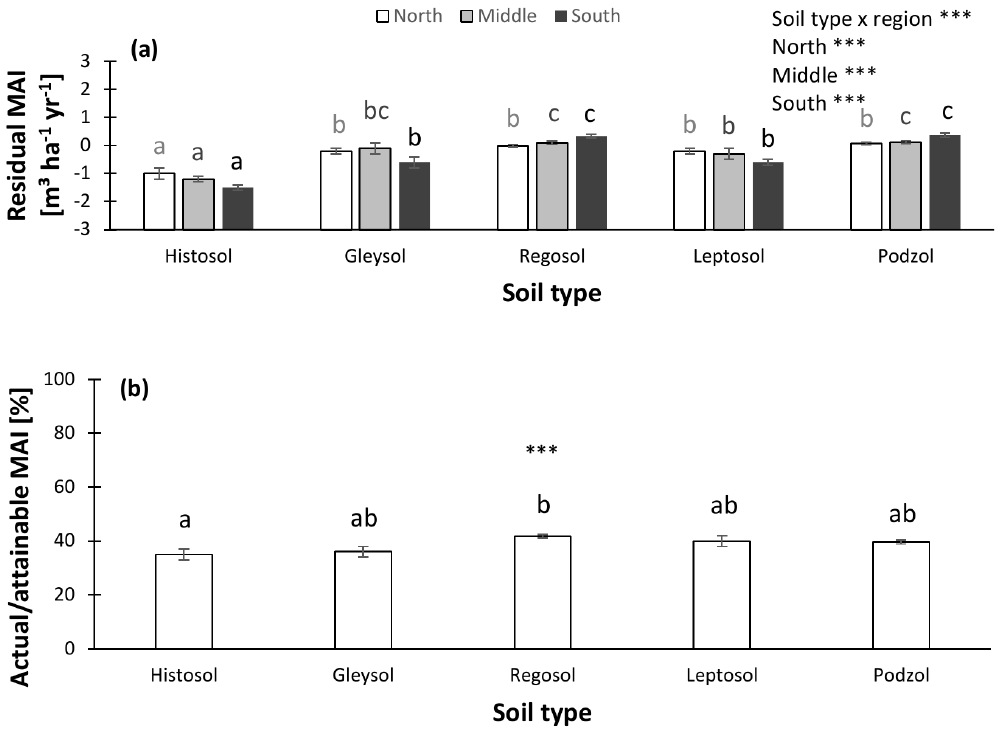
Figure 6. Normalized productivity per soil type. (a) Productivity normalized following method 1 (residual mean annual increment – MAI) vs. soil type. (b) Productivity normalized following method 2 (actual / attainable mean annual increment – MAI for spruce) vs. soil type. In panel (a) , separate analyses were performed for northern, middle, and southern Sweden, as the soil type effects differed among regions. ∗∗∗ Indicates significant differences at the P <0.01 level. Error bars represent the s.e.m.